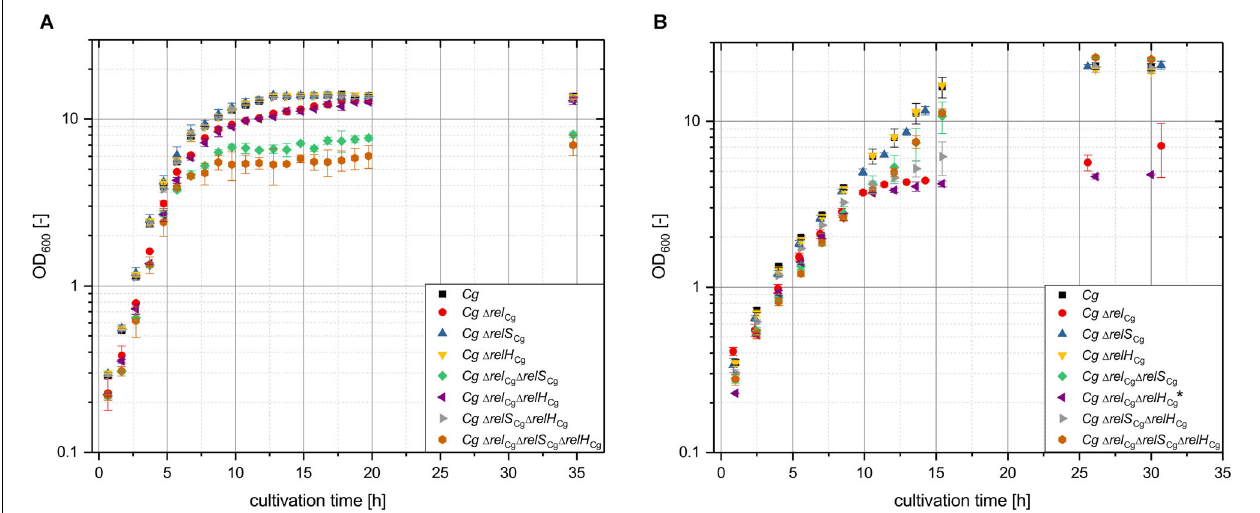
FIGURE 2 | Effect of the deletion of putative (pp)pGpp metabolism associated genes on the growth of C. glutamicum CR099 in complex CASO broth (A) and minimal CGXII medium (B) . To preclude possible enrichment of suppressor mutants all cultures were inoculated from precultures in complex CASO broth. An initial OD 600 of 0.2 was used for the cultivation in CASO broth. For the growth analysis in CGXII minimal medium, the precultures were washed in the main culture medium and then diluted to an OD 600 of 0.5. Mean values and standard deviations shown were calculated from three biological replicates. ∗ In the minimal medium cultivation of the strain CR099 (cid:49) relS Cg (cid:49) relH Cg , only two of the three replicas could be evaluated, because the third one showed a deviating growth behavior which did not correspond to the preliminary experiments and was therefore considered to be the result of a pseudoreversion.